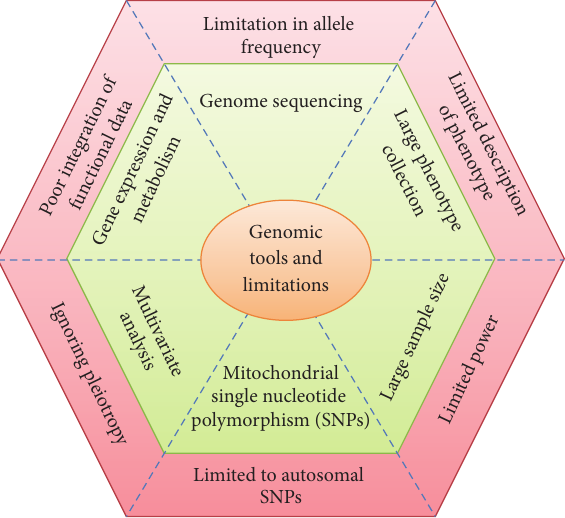
Figure 1: Illustration of various genetic tools for detection of genetic variations in species and their limitations in broad spectrum